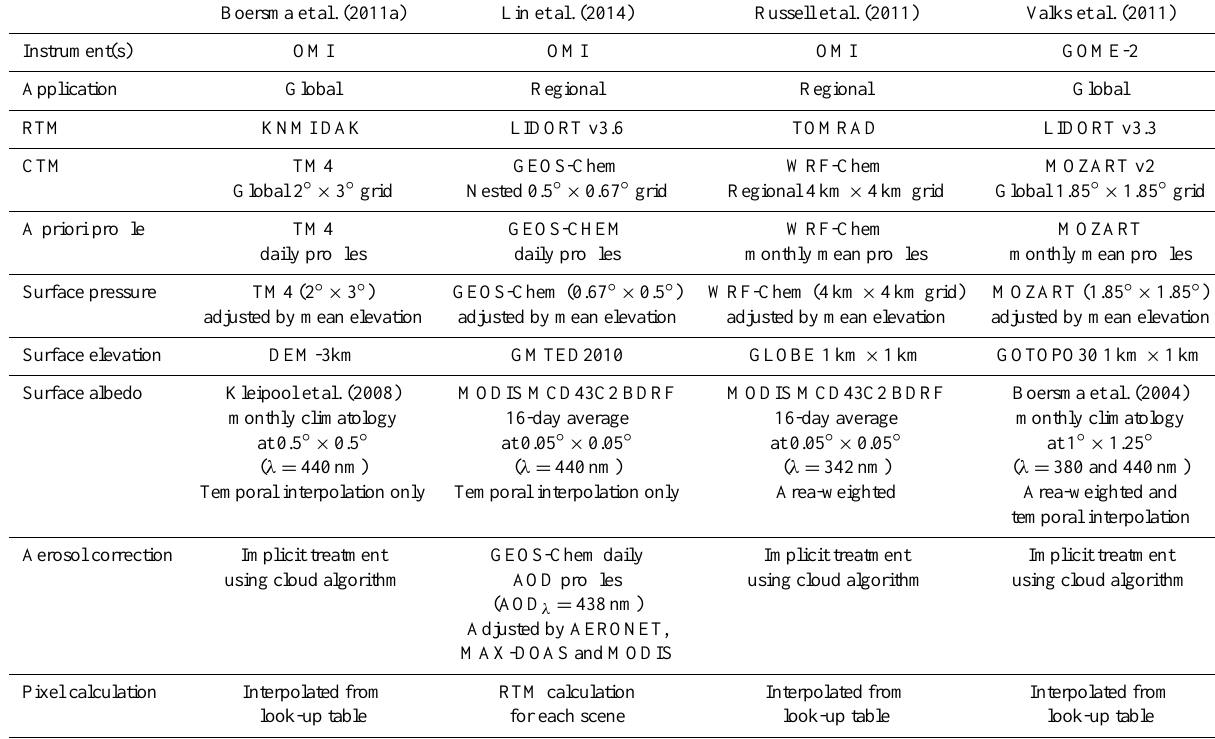
Table 2. Comparison of four different contemporary NO 2 AMF calculations. Readers are referred to cited references for full details. Boersma et al.